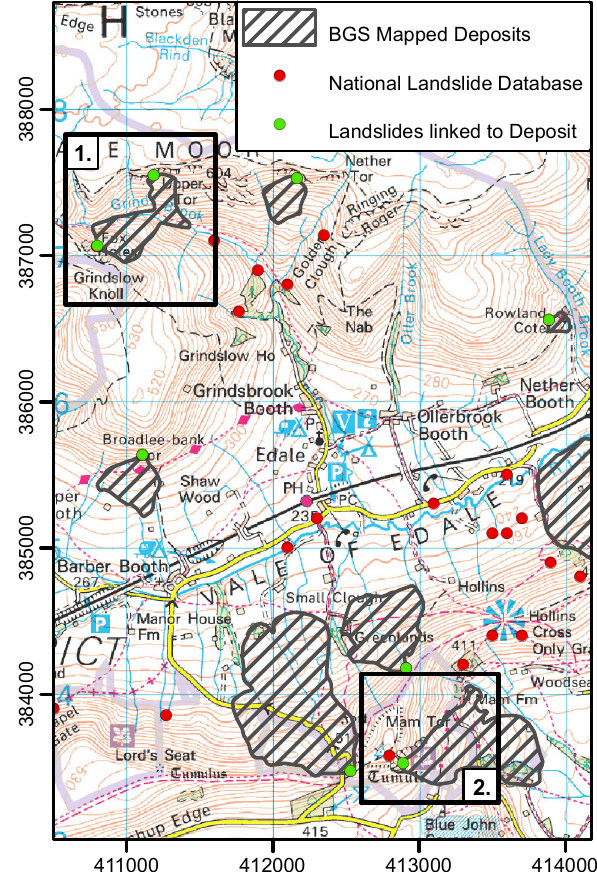
Figure 2. Example map from the Vale of Edale in Derbyshire, showing the locations of points in the NLD (red), and mapped land- slide deposits (hatched). Here, there were significantly more events in the database than there were polygons of mapped deposits, proba- bly due to the scale at which mapping took place (1:50000). Land- slide events (red) with no associated, mapped deposit were removed from subsequent analysis. Box 1 highlights a scenario where a sin- gle mapped deposit polygon is a composite of two separate land- slide events; hence these data are not included in later analysis. Box 2 shows an occasion where a landslide event (red), placed on the back scarp during QA, has been associated with a nearby polygon and linked (green). The spatial reference system is British National Grid; the units are metres. OS topography © Crown Copyright. All rights reserved. 100017897 /